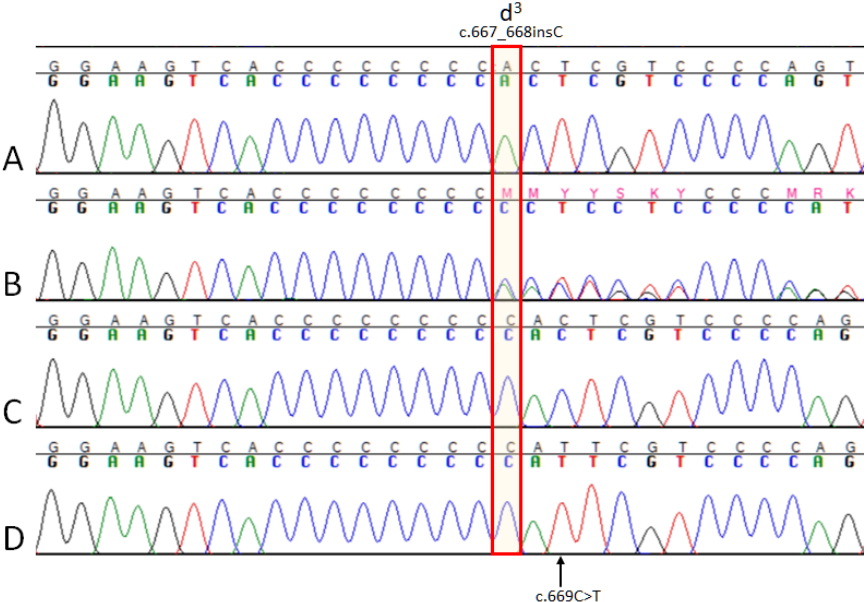
Figure 3. Sanger sequencing traces from MLPH exon 7. The red box highlights the location of the d 3 variant. A , a D / D mudi; B , a D / d 3 mudi; C , a d 3 / d 3 mudi; D , a d 3 / d 3 wolf-dog hybrid that also has a synonymous SNP (c.669C > T) 2 bp from the d 3 mutation. Table 1. MLPH variant genotypes in phenotyped Table 1 and supplementary Table S2 present the MLPH variant genotypes from the available